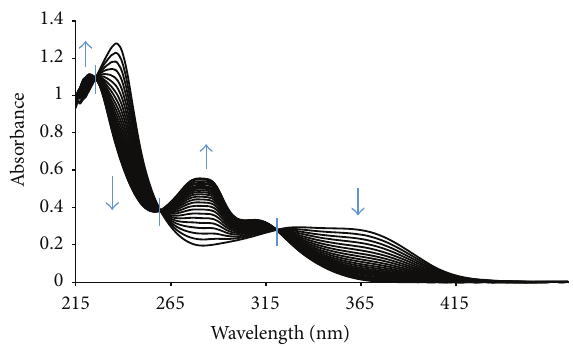
Figure 1: Evolution of the electronic absorption spectra of 5.88 × 10 −5 M NIS in ethanol subjected to a continuous irradiation with a 390 nm monochromatic beam (total irradiation time 2000 s at a radiant power of 𝑃 390 = 7.76 × 10 −7 einstein.s −1 .dm −3 ). The arrows indicate the direction of the peaks’ evolution during the photoreactionandtheverticallinescrossthespectraattheisosbestic points (232, 259, and 320